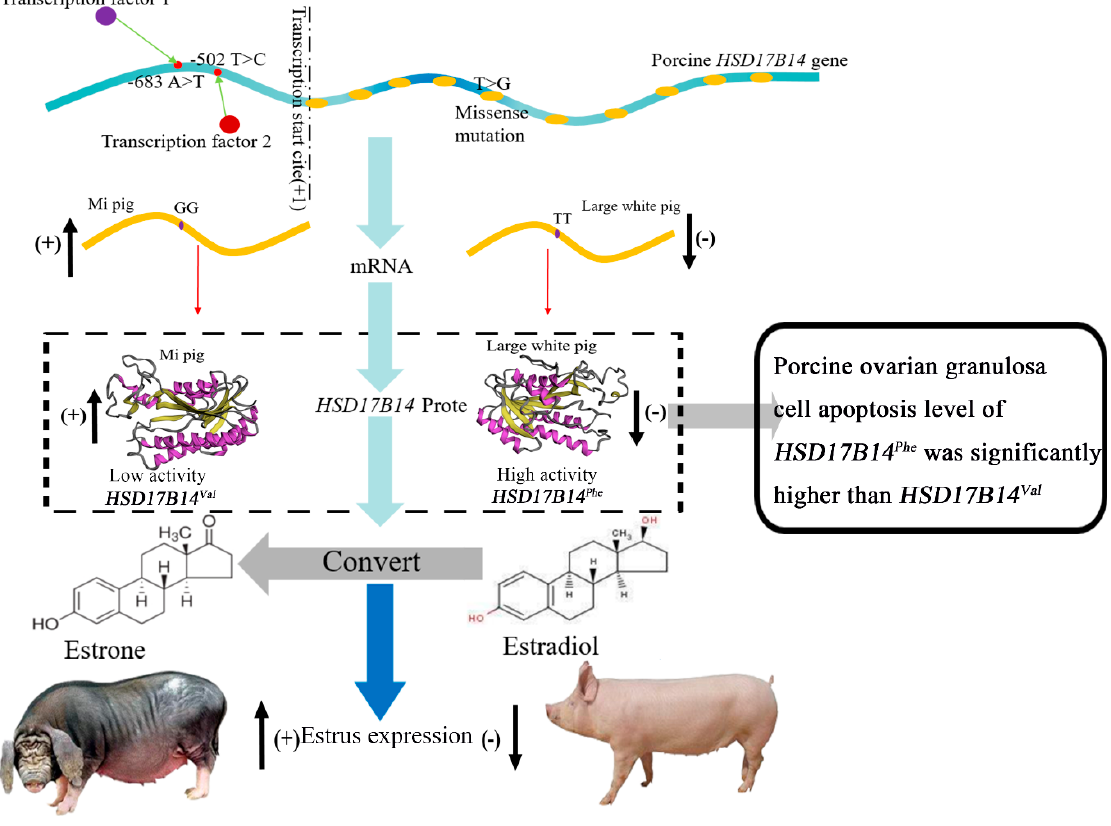
Figure 6. Regulation mechanism of the porcine HSD17B14 gene on estrus signs in Large White and Mi gilts.